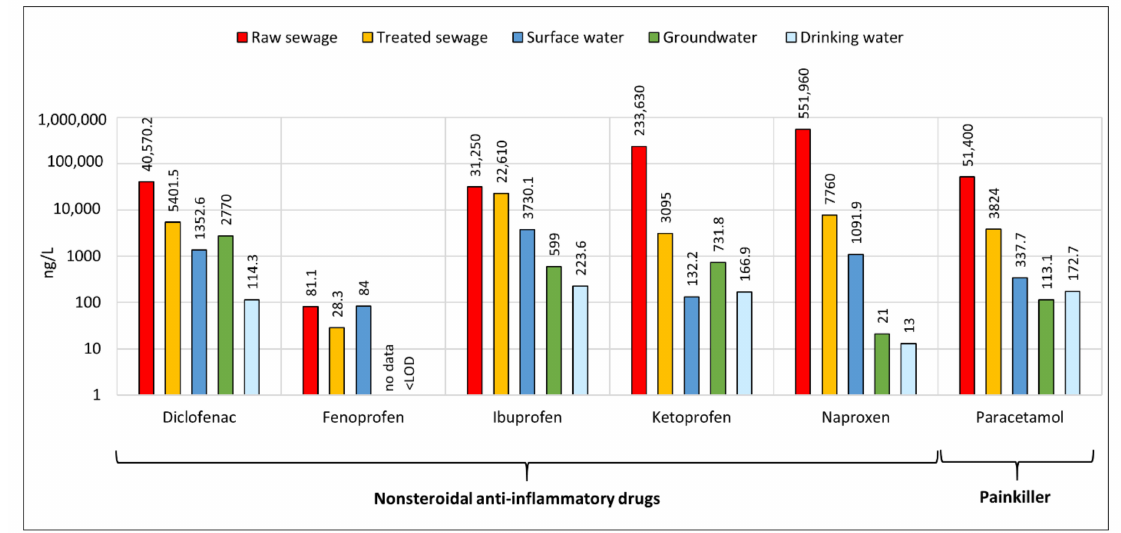
Figure 5. Variations in maximum concentrations of selected NSAIDs and one of the painkillers in different water sam- ple